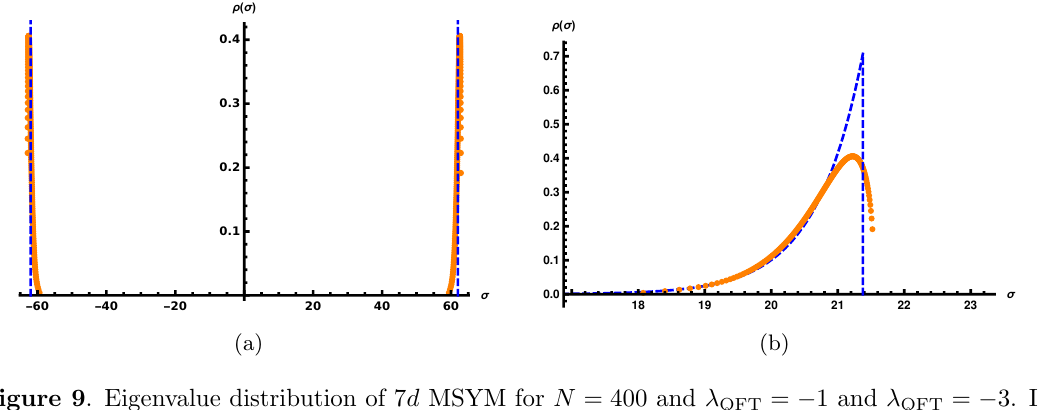
Figure 9 . Eigenvalue distribution of 7 d MSYM for N = 400 and (cid:21) QFT = (cid:0) 1 and (cid:21) QFT = (cid:0) 3. In the left panel we compare numerical results for (cid:21) QFT = (cid:0) 1 against the eigenvalue density (D.3), while on the right panel we compare numerics for (cid:21) QFT = (cid:0) 3 against the analytical solution